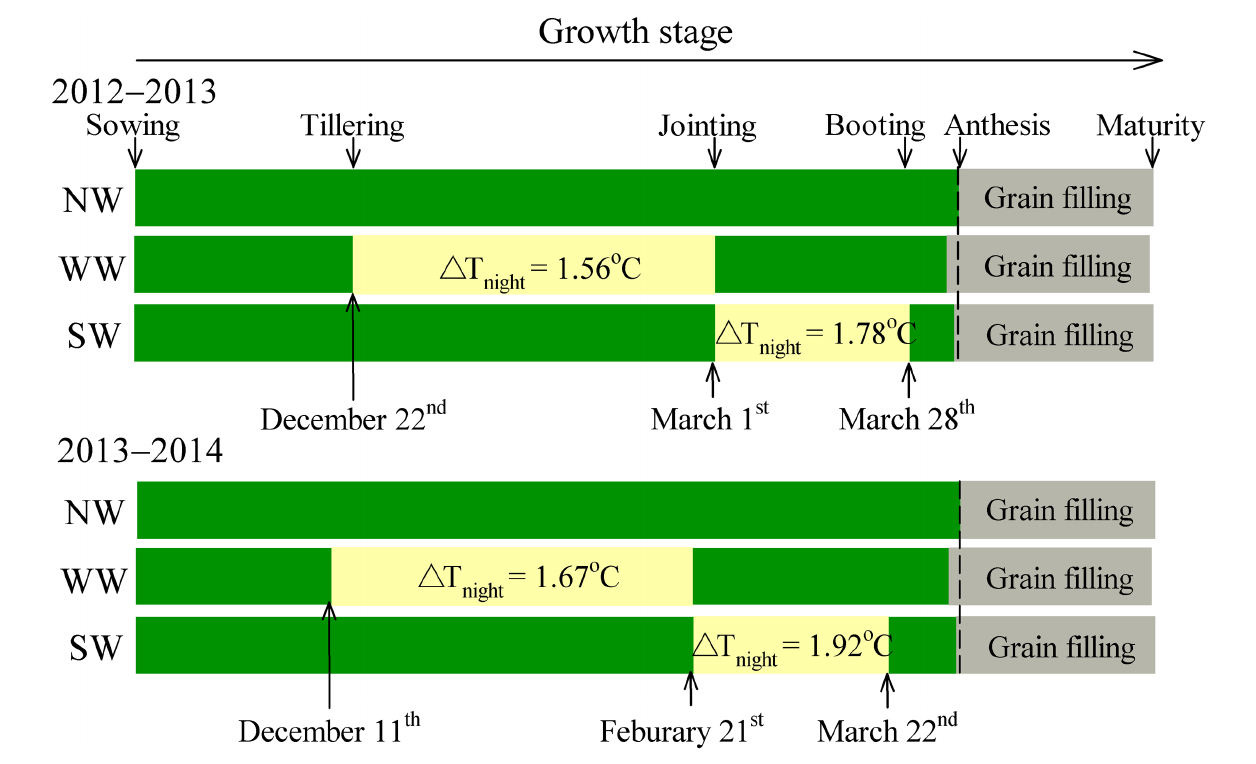
FIGURE 1 | Schematic representation of experimental design and treatments. WW and SW refer to night-warming during the winter and spring seasons, respectively. NW refers to the no warming control. (cid:49) T night refers to the increase in mean night temperature between treatments and the control. Mean night temperature is the mean in all temperature data on a 10-min interval from 19:00 to 07:00 h.